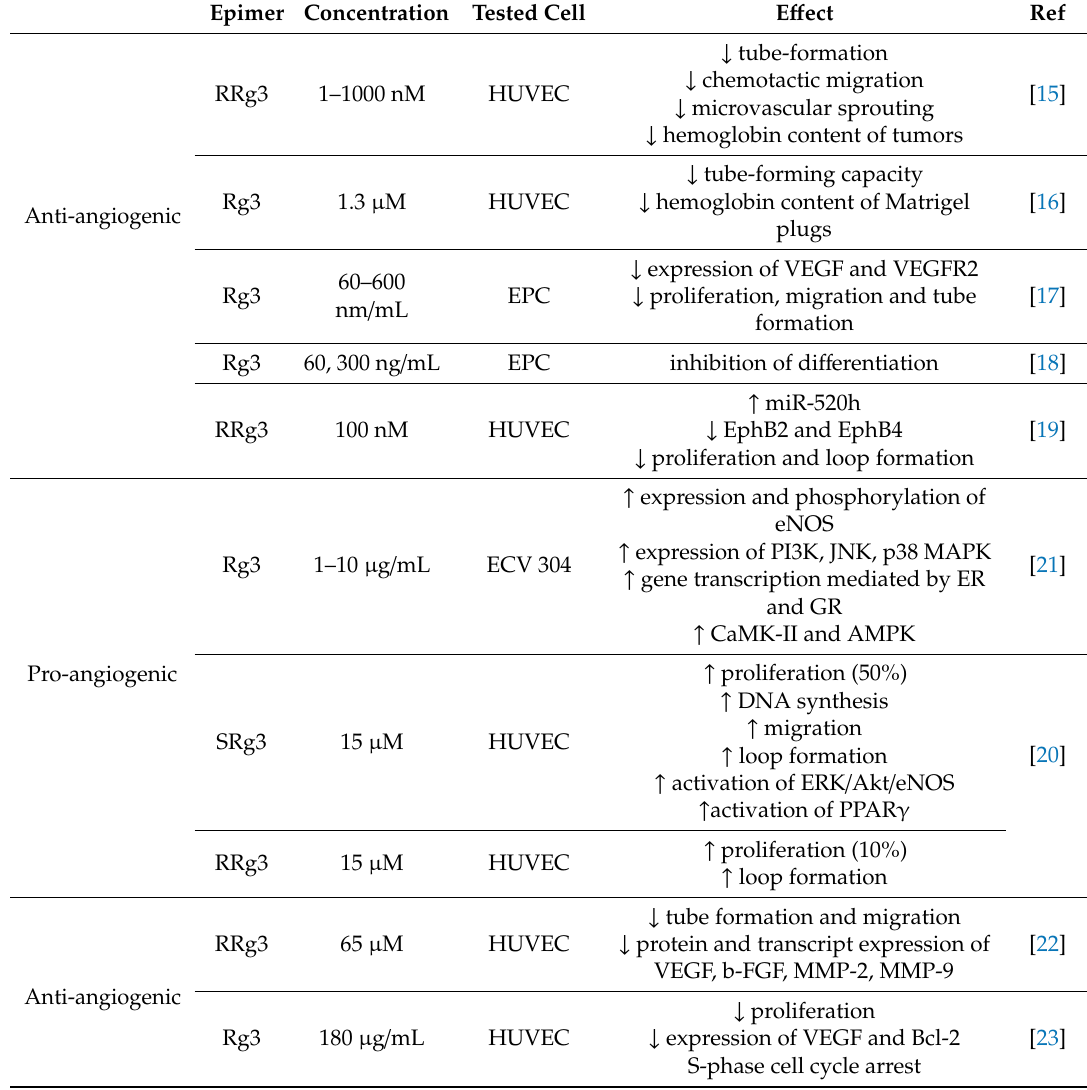
Table 1. Controversies on the proangiogenic or anti-angiogenic e ff ects of Rg3 on endothelial cells. Epimer Concentration Tested Cell E ff ect